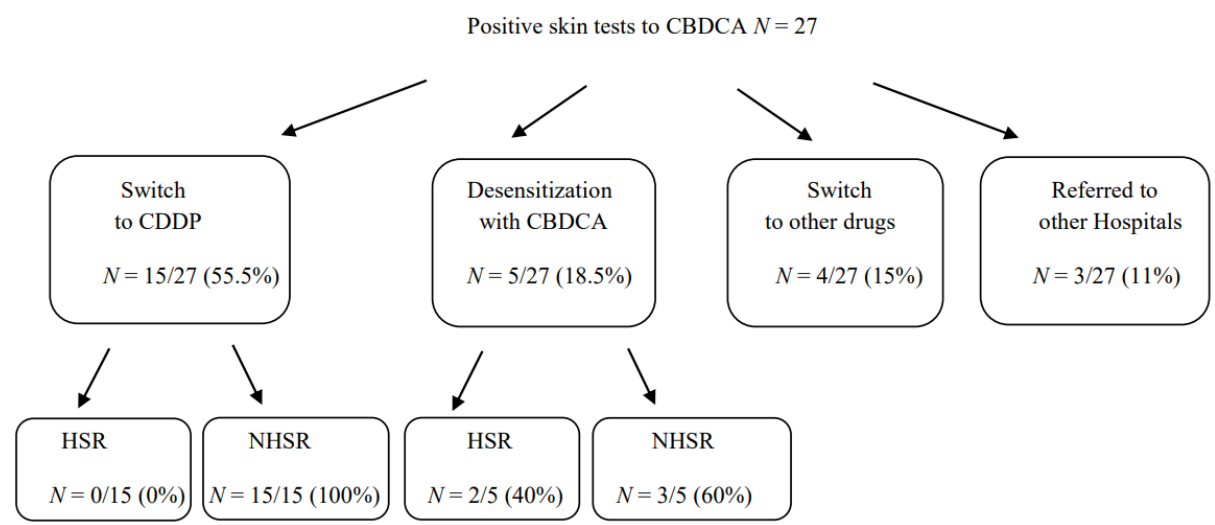
Figure 3. Therapeutic approaches in patients with HSR to CBDCA with positive skin tests. Abbreviations: HSR, hypersensi- tivity